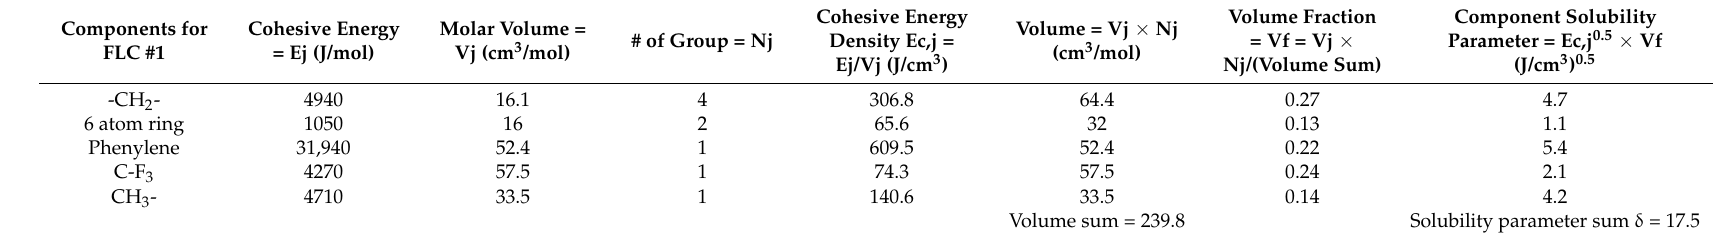
Table 7. Calculation process of the solubility parameter based on the molecular structure of FLC#1.